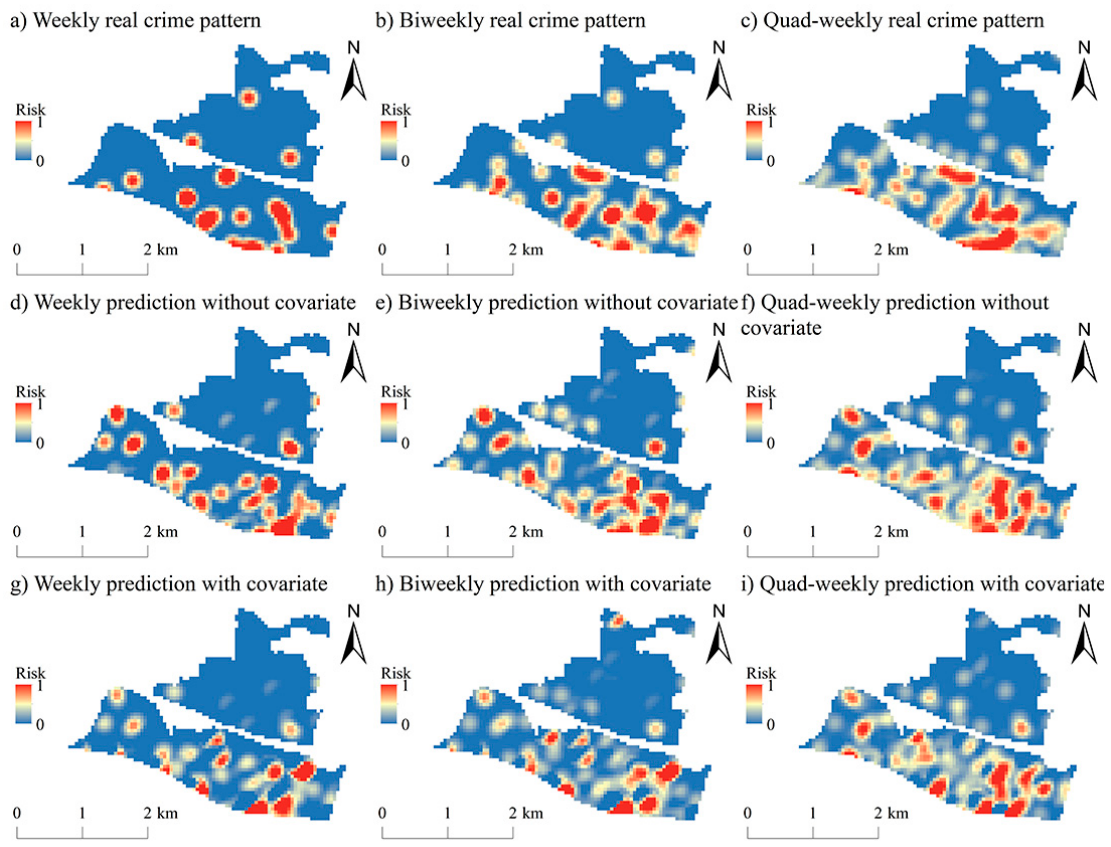
Figure 6. The real crime pattern ( a – c ), the predictive results without the covariate ( d – f ), and the predictive results with the covariate ( g – i ) for the weekly, biweekly, and quad-weekly basis.